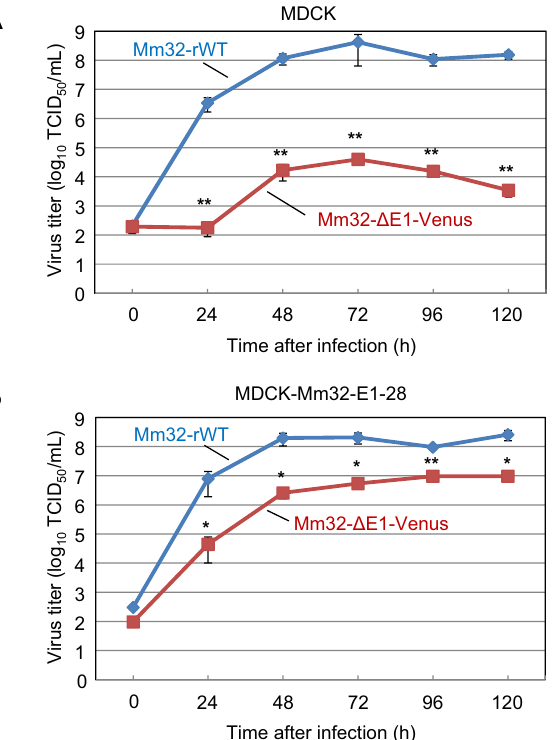
Figure 3. Growth kinetics of Mm32-rWT and Mm32-ΔE1-Venus. ( A ) MDCK cells and ( B ) MDCK- Mm32-E1-28 cells were infected with Mm32-rWT or Mm32-ΔE1-Venus at an MOI of 0.2, respectively. The culture supernatants were collected at the indicated time points, and the viral titers (TCID 50 /mL) were determined in MDCK-Mm32-E1-28 cells. The results are reported as the mean titers with standard errors of the mean for three independent experiments. The mixed ANOVA indicated the significance of the differences between growth kinetics of Mm32-WT vs. Mm32-ΔE1-Venus in ( A ) MDCK cells (p < 0.001) and ( B ) MDCK- Mm32-E1-28 cells (p < 0.001). The asterisks indicate significant differences at each time-point (*p < 0.05; **p < 0.01 by Holm